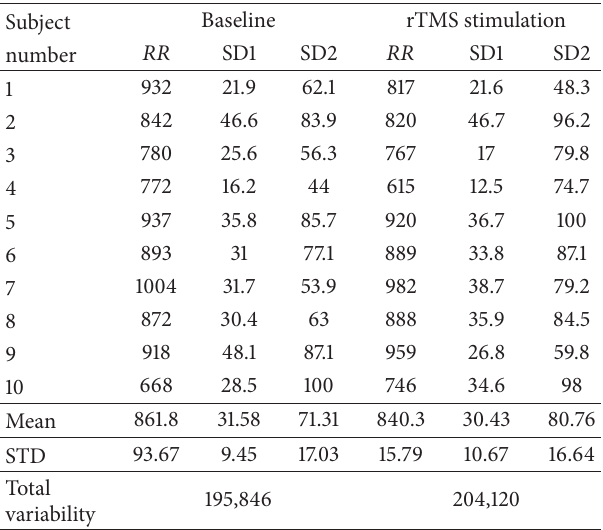
Table 1: Comparative measurements at baseline and during stimu- lation.